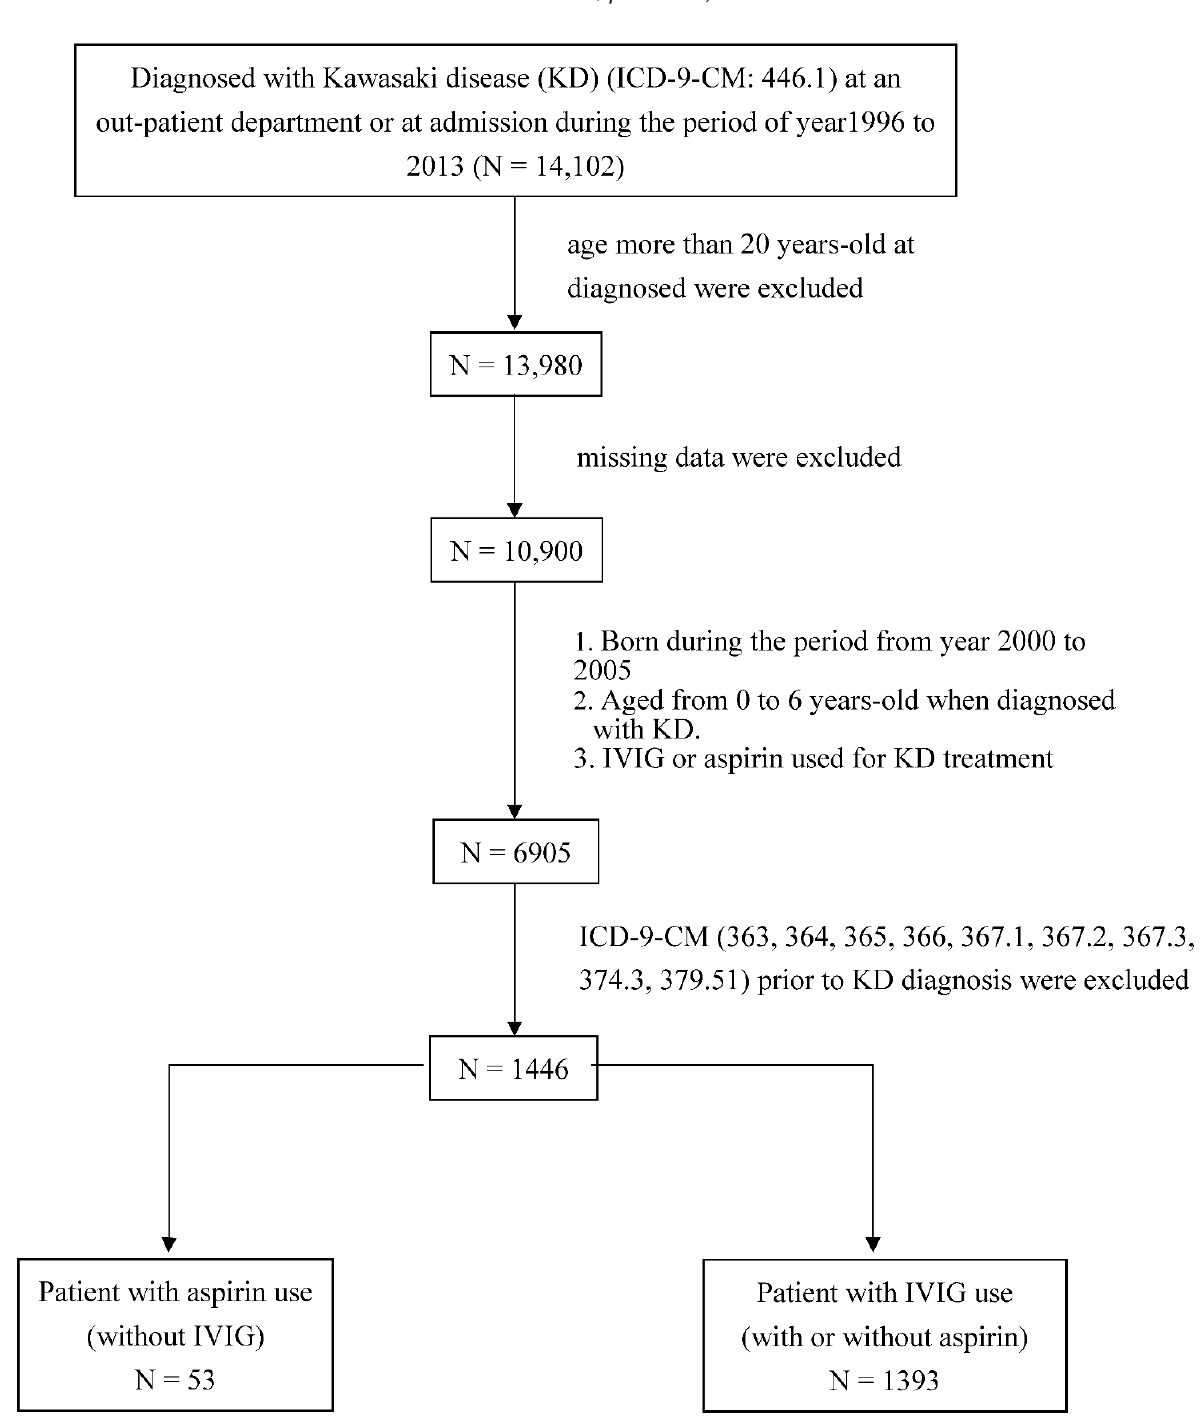
Figure 1. Flowchart of study subjects collected.